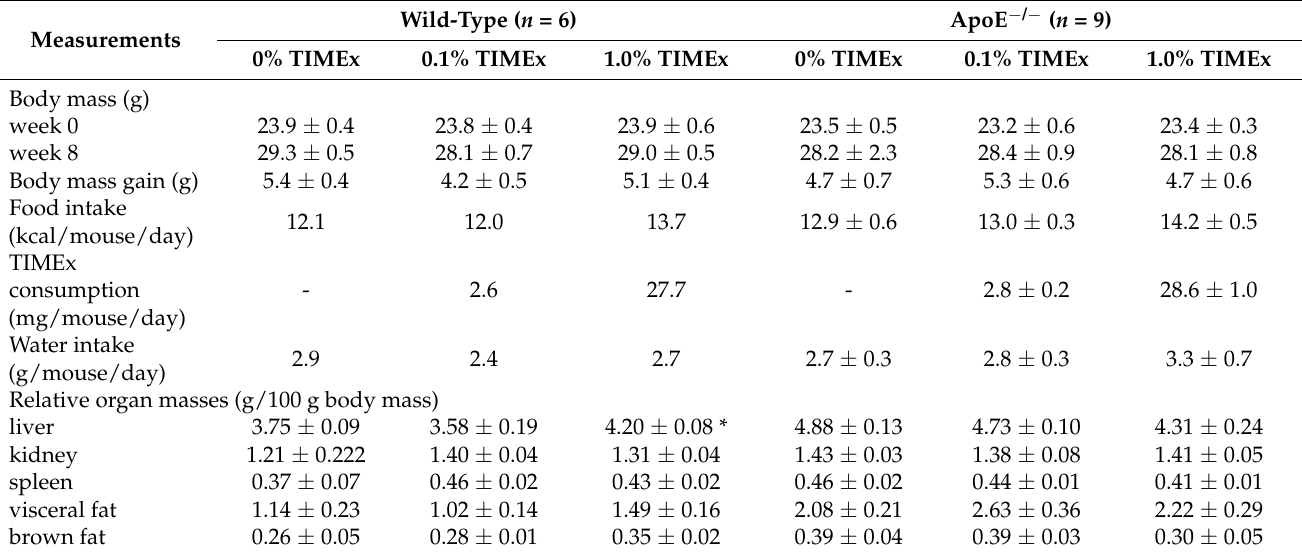
Table 1. Effects of the consumption of a hot-water extract of thinned immature mango on the growth parameters and organ masses of the mice.